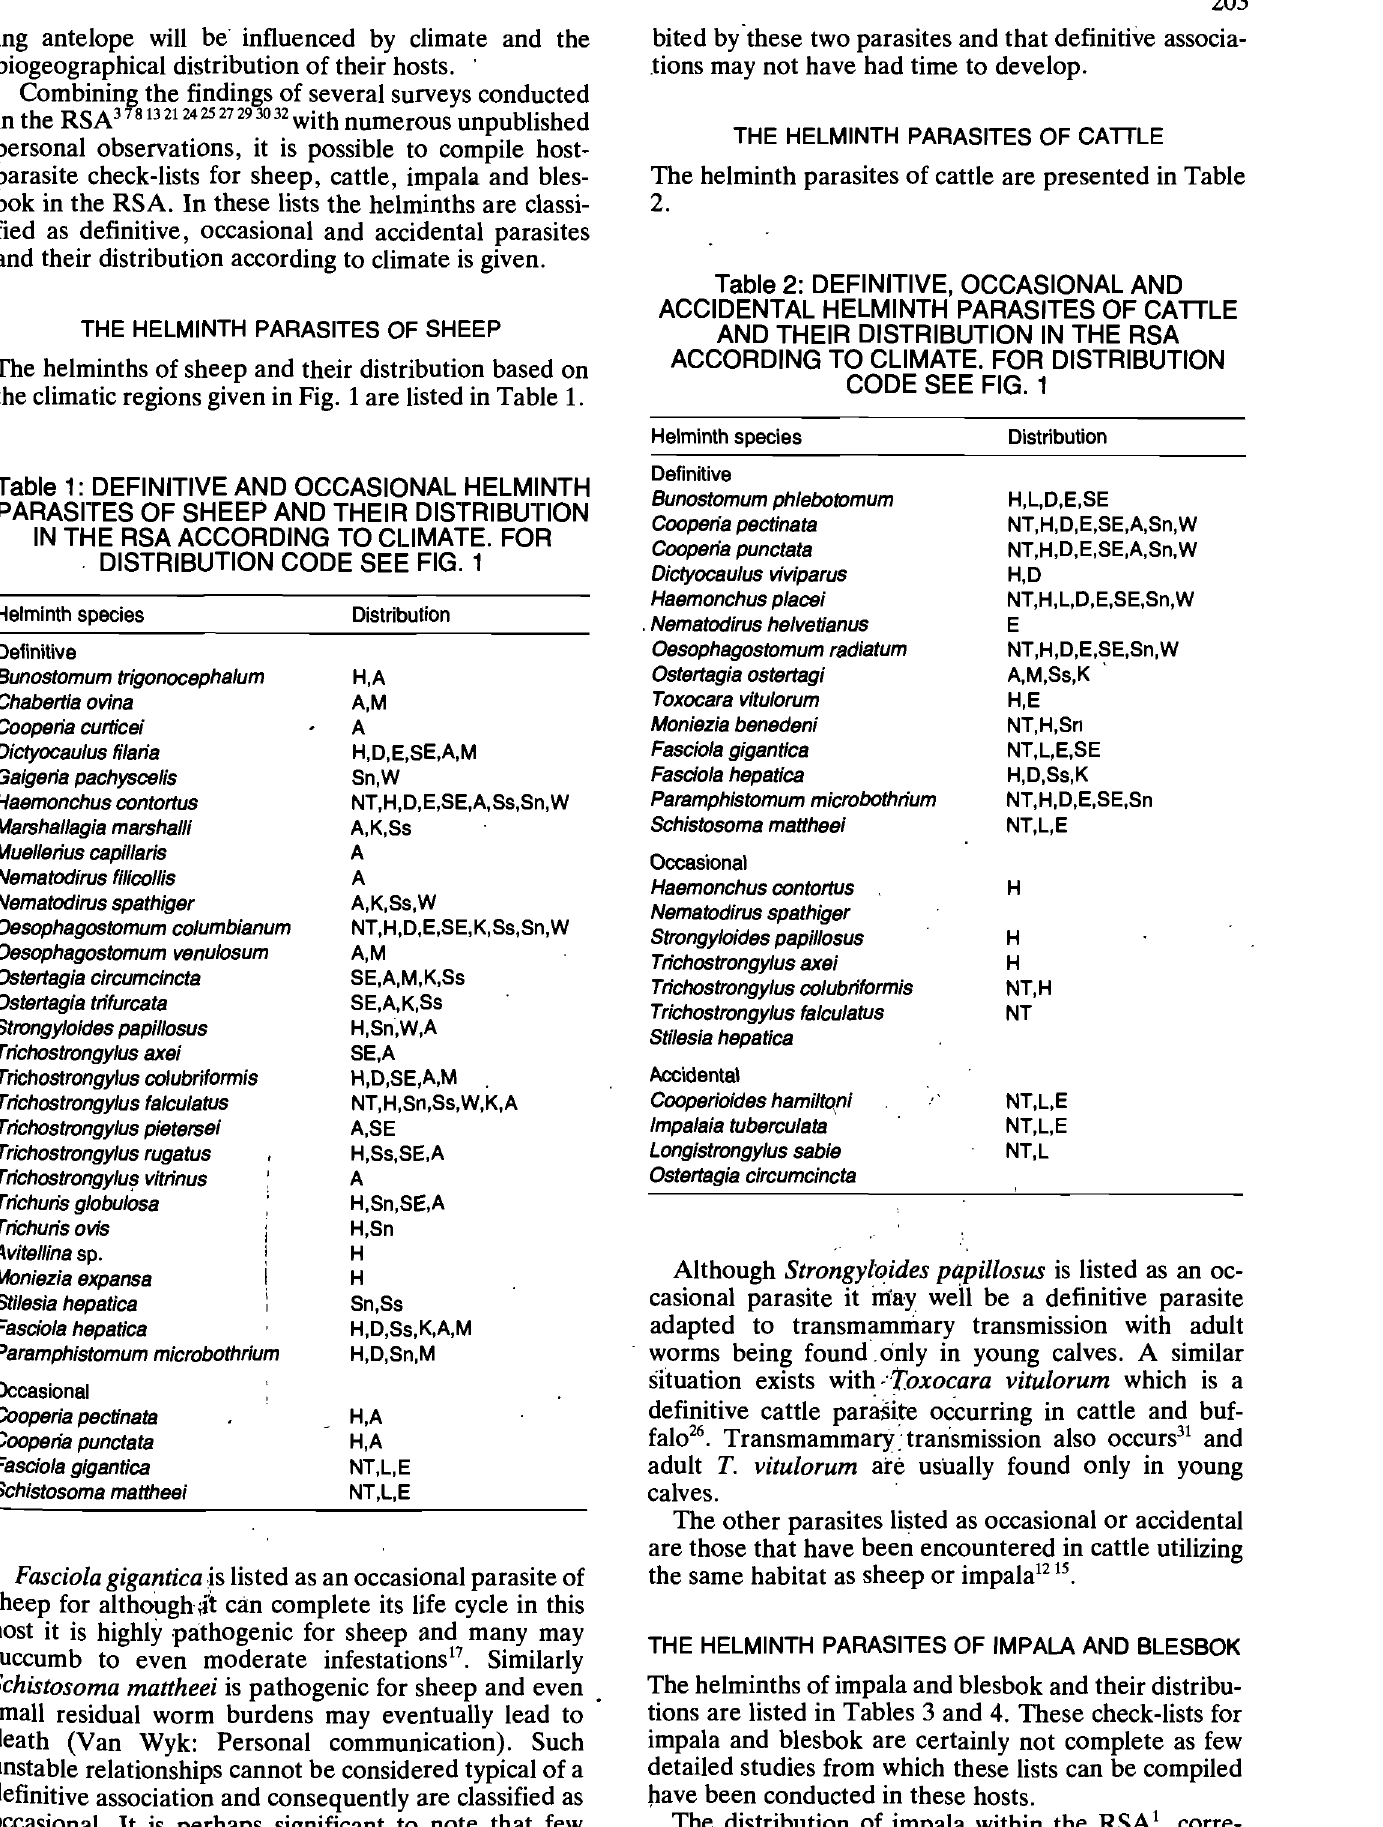
Table 2: DEFINITIVE, OCCASIONAL AND ACCIDENTAL HELMINTH PARASITES OF CATTLE AND THEIR DISTRIBUTION IN THE RSA ACCORDING TO CLIMATE. FOR DISTRIBUTION CODE SEE FIG.